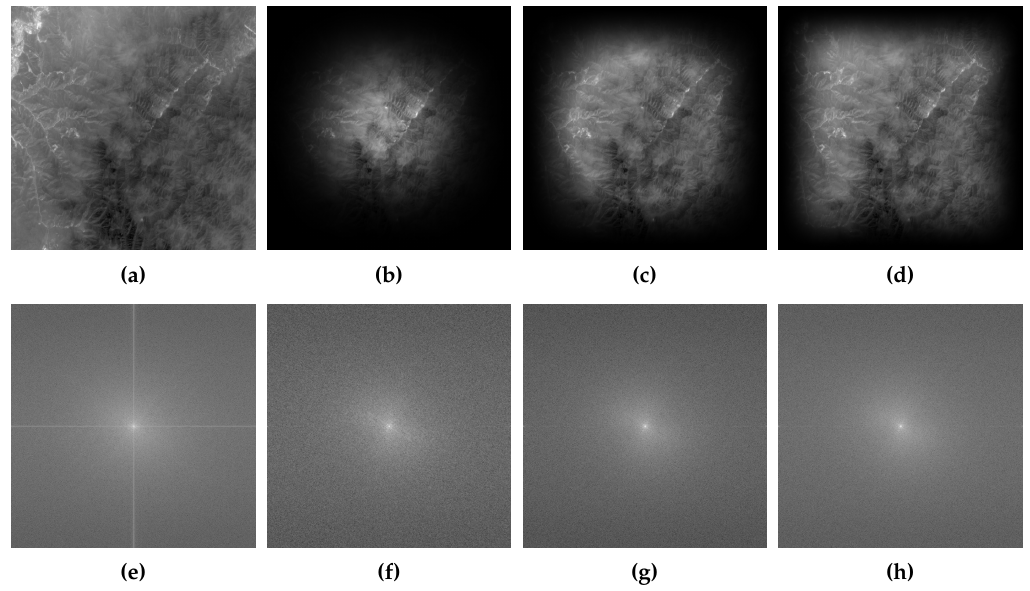
Figure 2. The resulting images of image filtered by different window functions and the corresponding amplitude spectrum. ( a ) is the original image, its size is 1000 × 1000 pixels. ( b – d ) are the result images after filtering by Blackman, flap-top and raised-cosine window function, respectively. ( e – h ) are the corresponding amplitude spectrum of ( a – d ), respectively. It is worth noting that the amplitude spectrum was operated logarithmically for clear